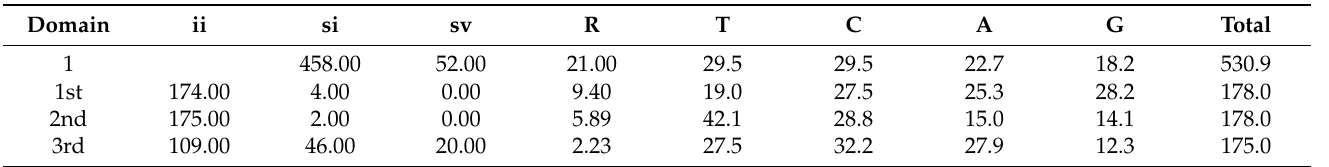
Table 2. Sequence variation of the CO I gene and average nucleotide frequencies of CO I partial sequences of Scaridae (%).